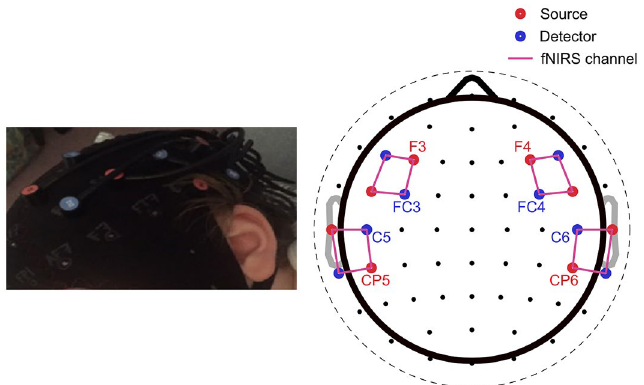
Figure 1. Illustration of experimental set-up on the infant. Left: an image of the cap on a participant’s head. Right: The 8 × 8 source-detector montage that was placed over the temporal and prefrontal regions of the infant participants, resulting in four regions of interest. Sources are colored red, detectors are blue, and channels are indicated by purple